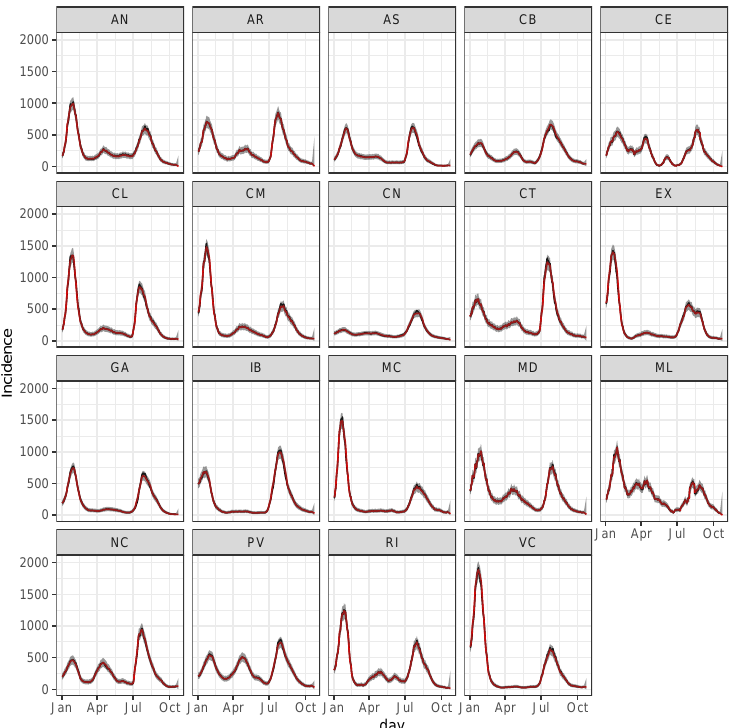
Figure 4. Daily incidence for year 2021. Posterior predicted distribution summarized by the median (red) and 99% credible intervals (shaded grey area) for observed days (black) This is the estimation of (1) for observed and future predictions starting from d = 1 day ahead up to d = 7 days ahead, namely from 12 October till 18